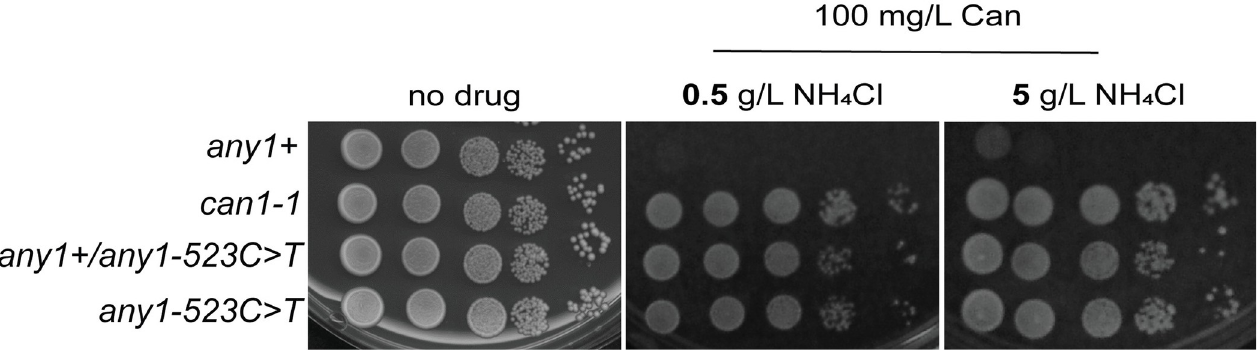
Fig 3. any1-523C > T is a dominant allele. Serial 10-fold dilutions of indicated strains spotted on synthetic media lacking arginine and containing the indicated amount of ammonium chloride and canavanine (Can). The strains are haploid and express either one copy of any1 ( any1+ , can1-1 , any1-523C > T ) or two copies ( any1+/any1-523C > T ). The strain with two any1 alleles contains any1+ in its endogenous location and any1-523C > T inserted into the left arm of chromosome I. Strains used: KT1191, KT795, KT1570, KT1403.